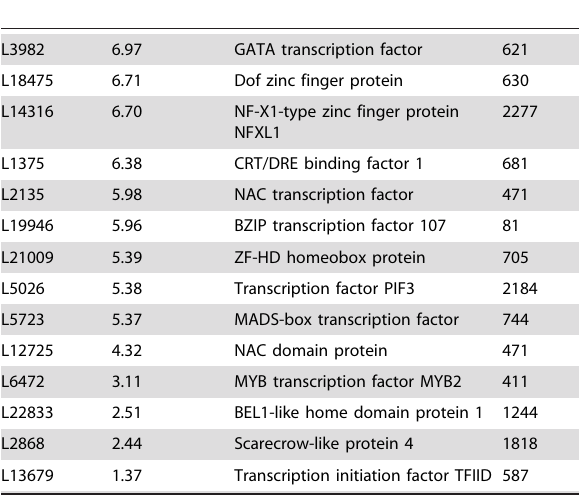
Table 5. Expression abundance of up-regulated transcriptional factors during rhizome formation.